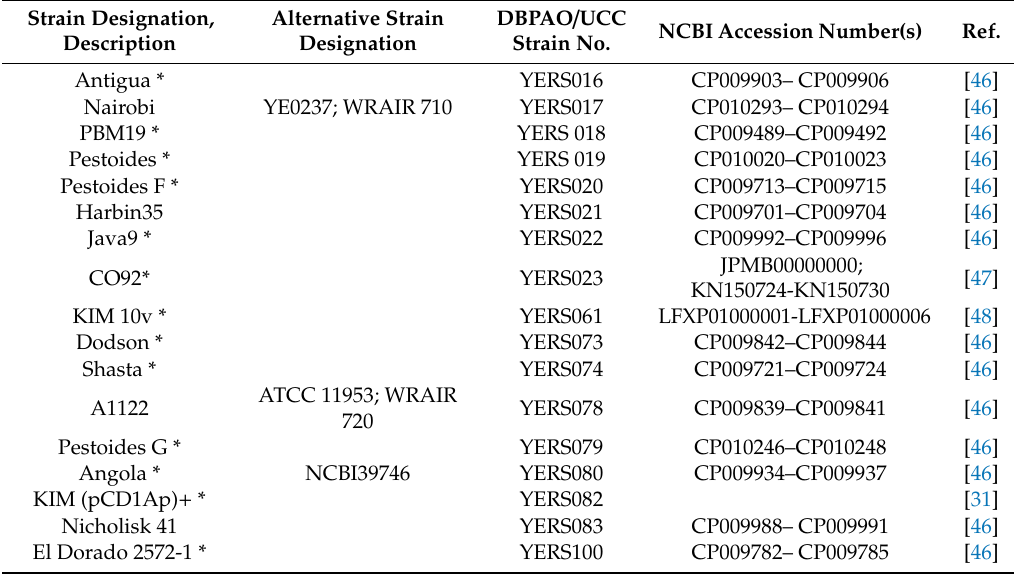
Table 10. Y. pestis strains used in this